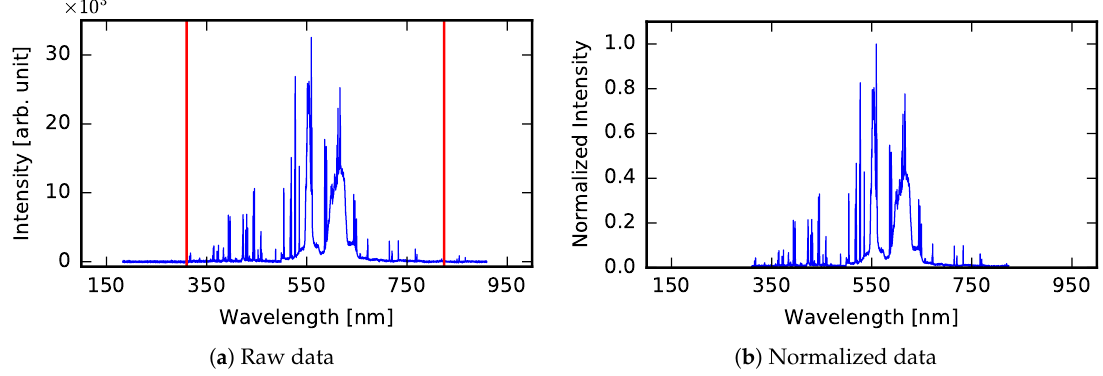
Figure 3. Visualization of data preprocessing for single sample spectrum from Class A. Figure ( a ) depicts an example of a raw spectrogram with marked truncation points, ( b ) shows normalized